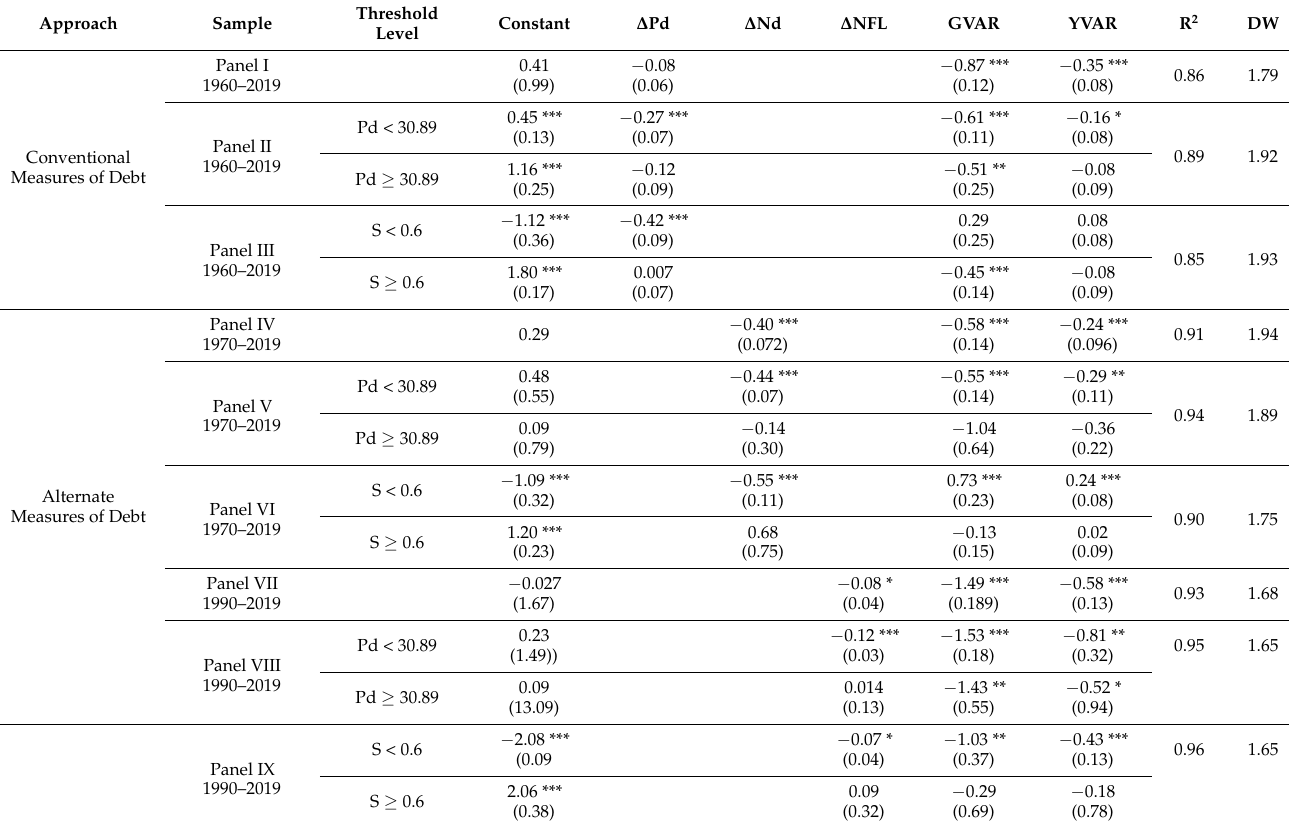
Table 2. Australia’s fiscal sustainability and threshold using conventional and alternate measures.